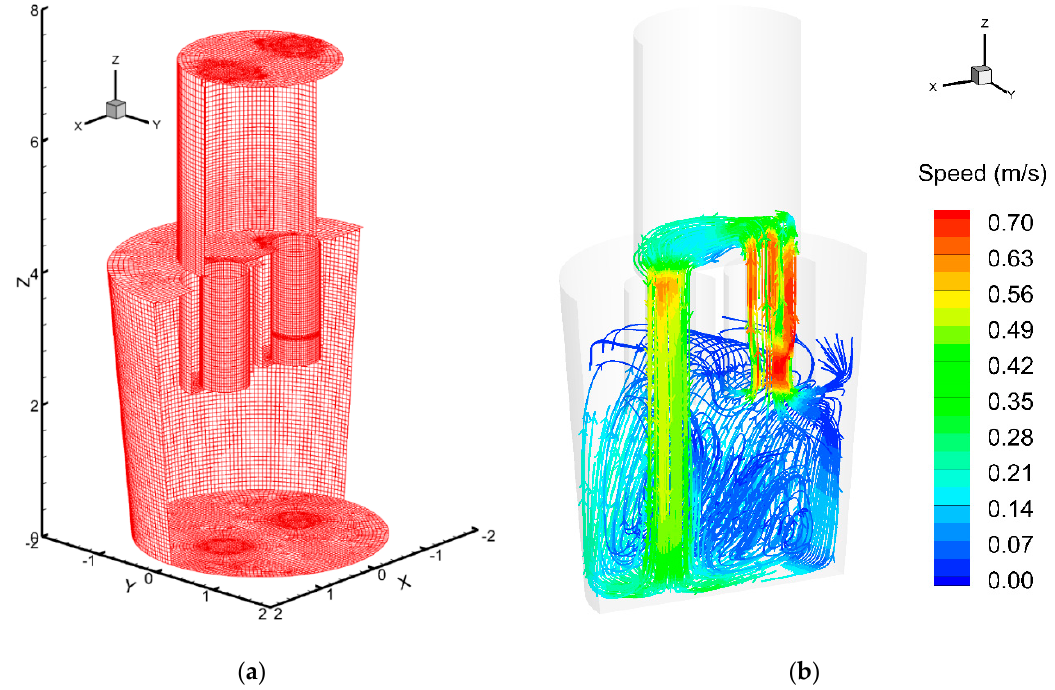
Figure 1. Fluid flow simulation during RH treatment: ( a ) Mesh generation; ( b ) 3D velocity streamlines.